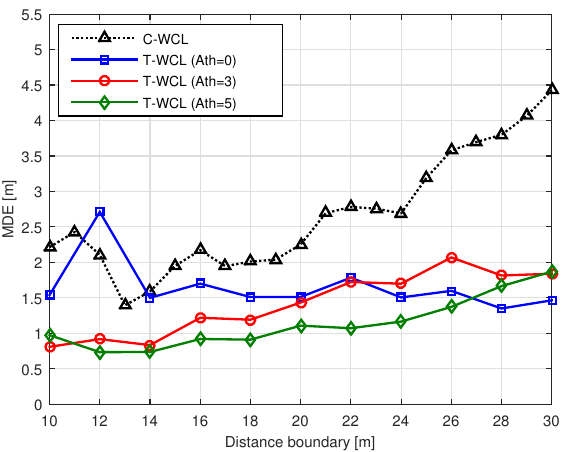
Figure 6. MDE performance according to the distance boundary with the intersection